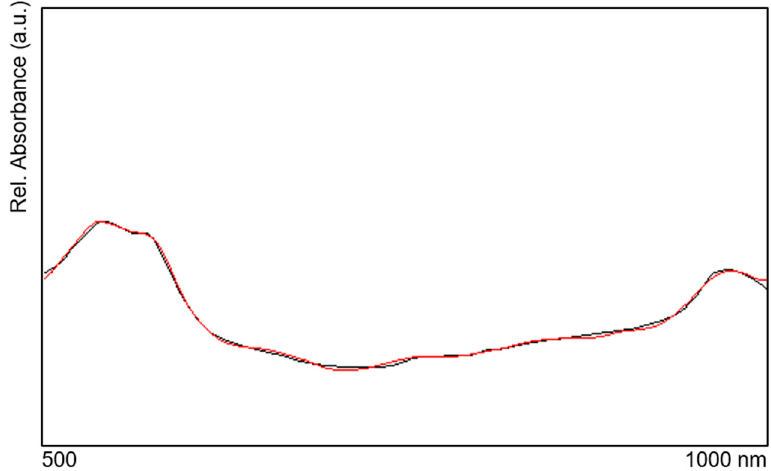
Figure 10. Measured spectrum (absorbance) (red) and reproduced spectrum by the model (black).